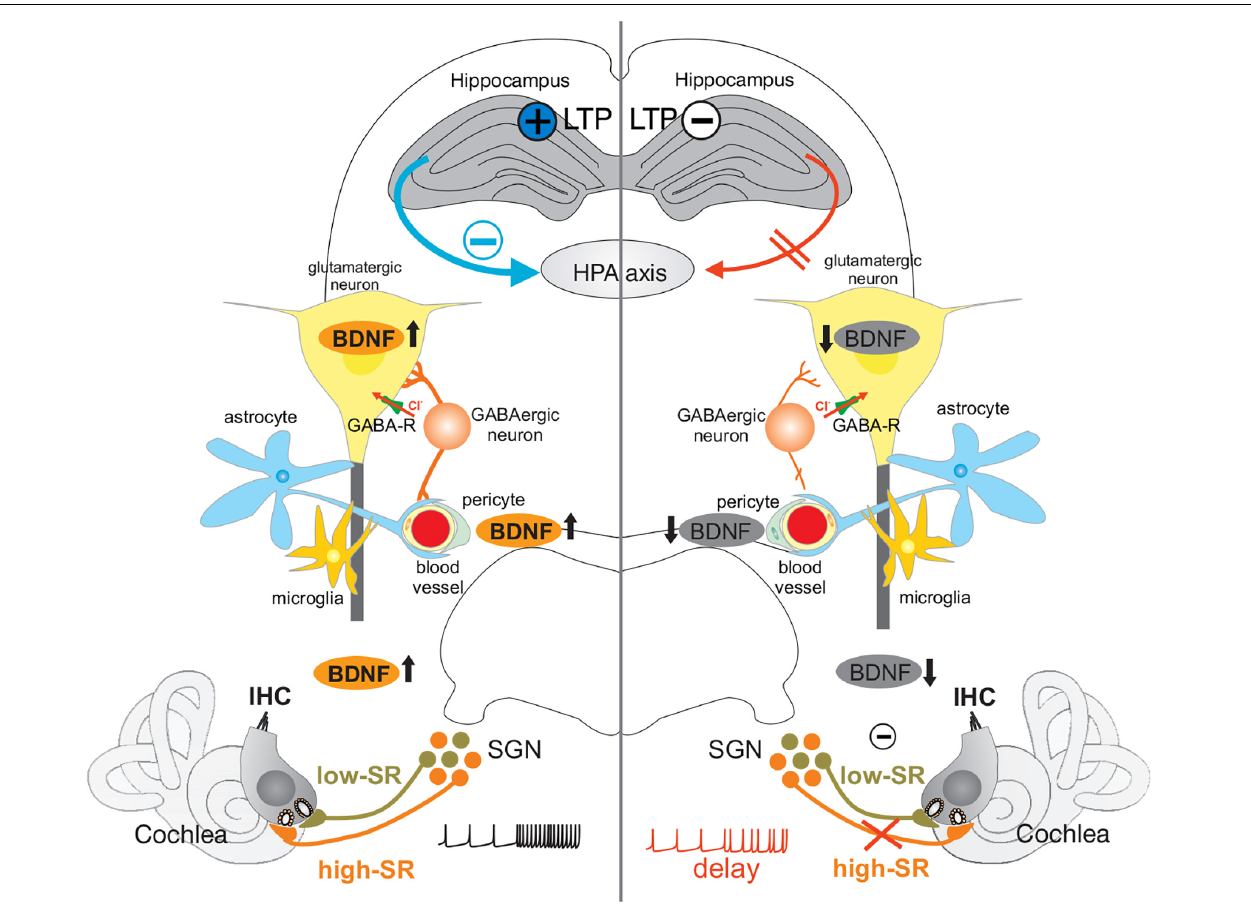
FIGURE 8 | Under healthy conditions (Left) , fast auditory processing (high-SR in orange) enables context-specific information processing in auditory and associated circuits (hippocampus, HPA axis) through upregulation of activity-dependent BDNF ( ↑ ). Increased central neural gain, represented by increased hippocampal LTP (black cross in blue circle), allows the facilitation of BDNF/PV-IN circuits by BDNF ↑ in glutamatergic neurons, and an increase in perisomatic inhibitory strength (GABAergic neuron contacting glutamatergic neuron) dependent on increased stimulus responses. These in turn provide a balanced HPA axis control (blue arrow and minus) and local hemodynamic supply (blood vessels) for a long-lasting improved signal-to-noise ratio and stimulus discrimination above noise (black spike train). During aging, or following acoustic trauma, acute, or congenital deafness (Right) , a critical loss of high-SR auditory nerve fibers (orange) occurs, leading to reduced auditory driving force and BDNF expression ( ↓ ). This is associated with reduced hippocampal LTP (black minus in white circle), reduced tonic-PV-IN strength (reduced synaptic contacts of GABAergic neurons on glutamatergic neurons), altered extra-hypothalamic stress control (red arrow to HPA axis), and possibly disturbed coupling of inhibitory neuronal activity to hemodynamic responses, leading to altered sound processing (red spike train). IHC, inner hair cell; SGN, spiral ganglion neuron; GABA-R, GABA receptor; HPA axis, hypothalamic-pituitary-adrenal axis; LTP, long-term potentiation; BDNF, brain-derived neurotrophic